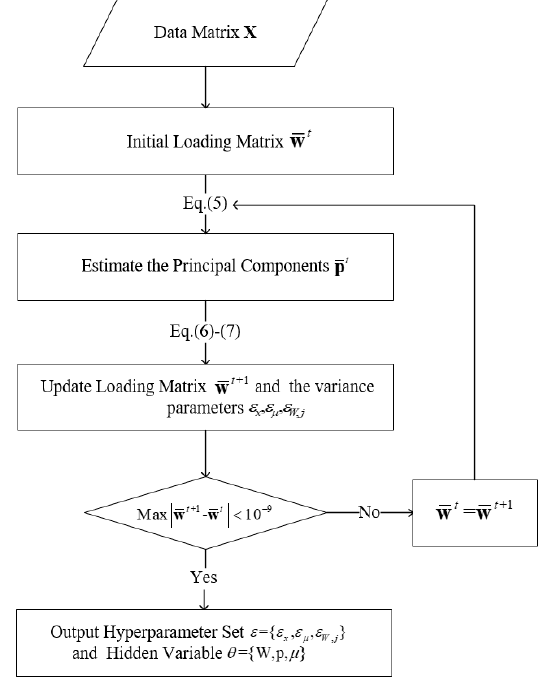
Figure 1. Flowchart of the VBPCA algorithm.